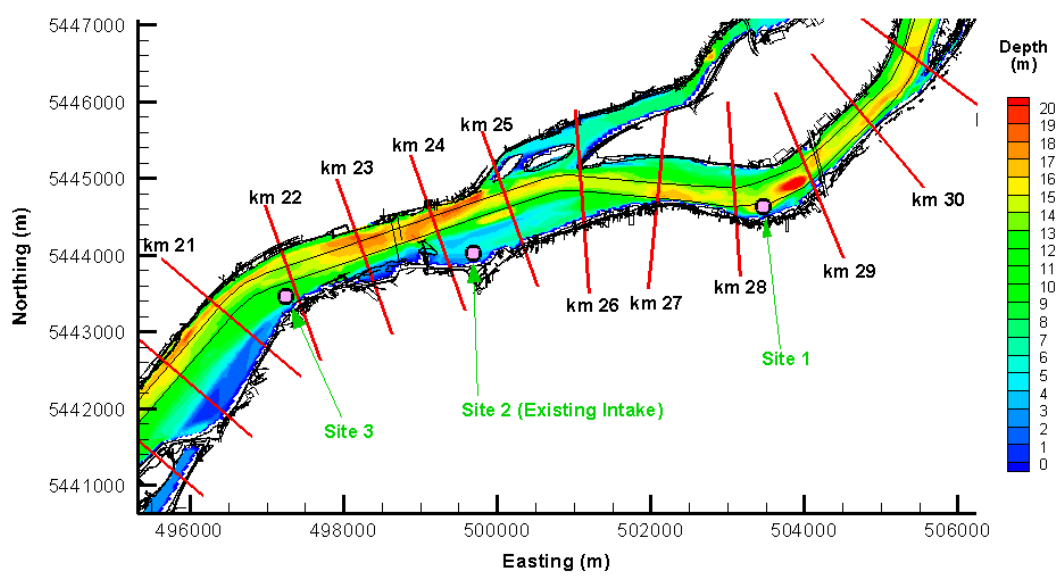
Figure 11. Location of candidate sites for additional water intake installation.